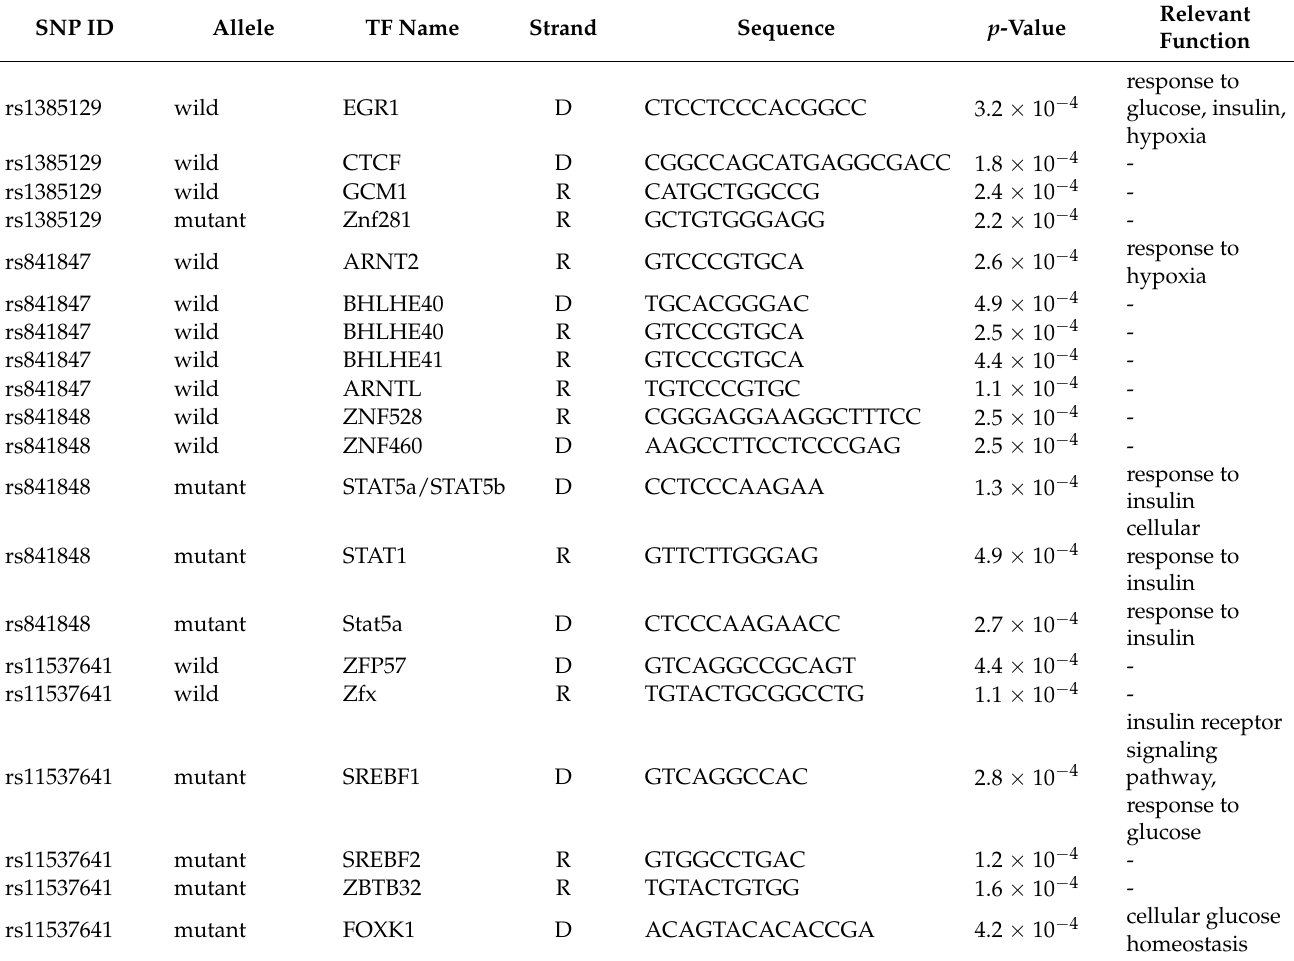
Table 2. Predicted transcription factor binding sites in the region of the examined SNPs. The table shows the binding sites (Sequence) of the transcription factors (TF name) affected by one of the alleles of the SNPs. The concerned DNA strand and the T2DM-specific function of the TFs are also described. The p -value refers to the binding probability of the